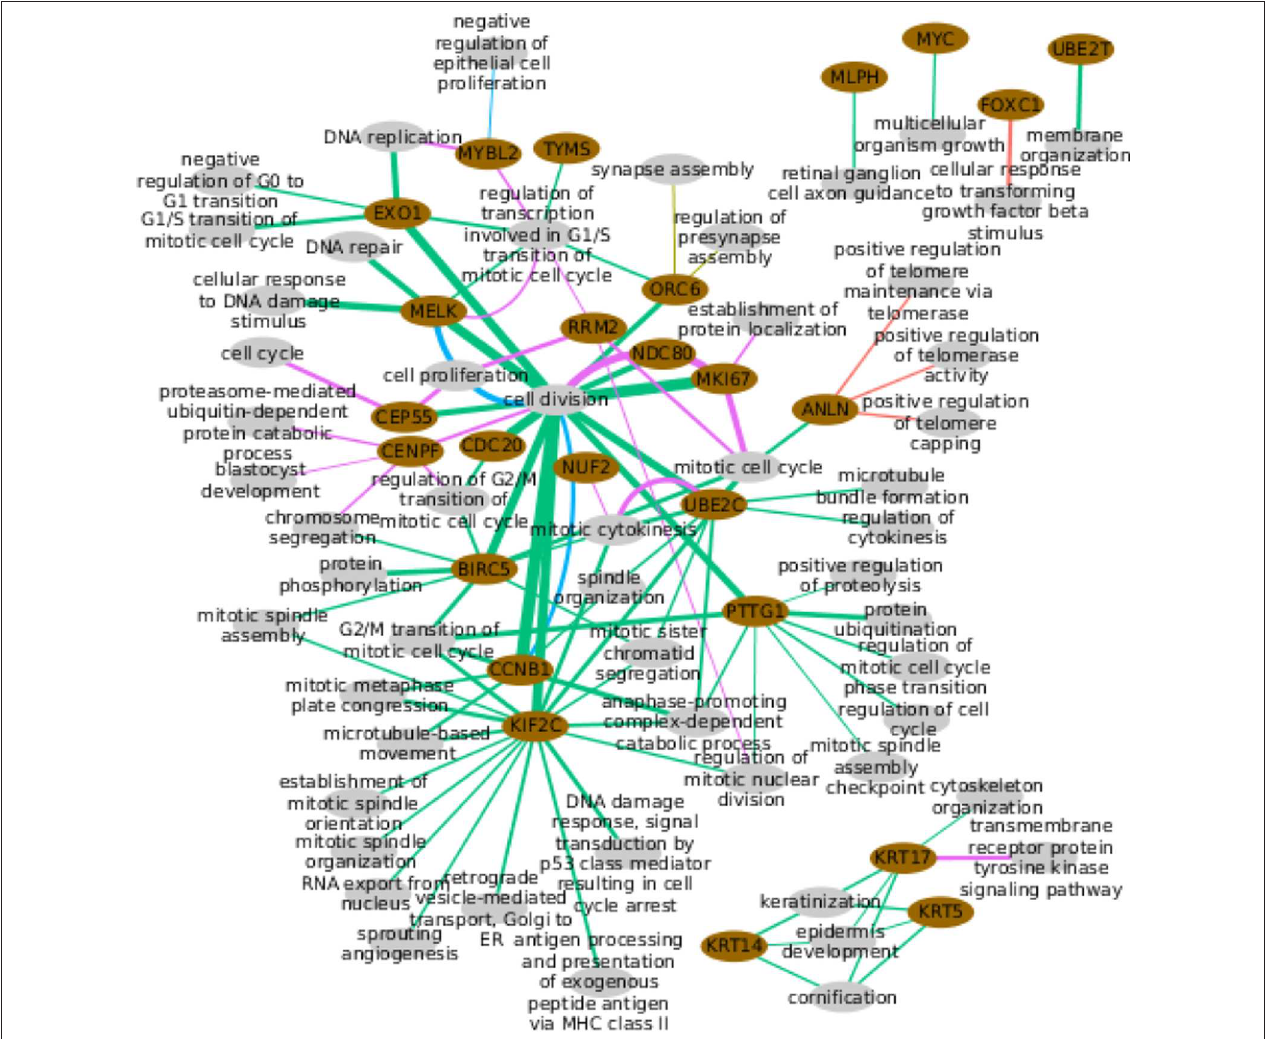
FIGURE 7 | Functional enrichment of the predictors selected per PAM50 gene. Pink ellipses represent PAM50 genes while the gray ellipses represent biological processes. Colored lines link genes with the processes they are significantly enriched to the corresponding subtype. Wider lines indicate a higher number of PAM50 gene predictors in the